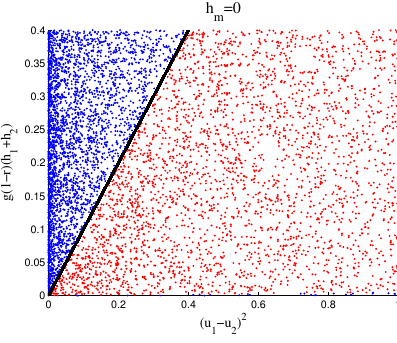
Figure 12. Hyperbolicity check for the two-layer system (1.1): The blue points represent the range of hyperbolicity.